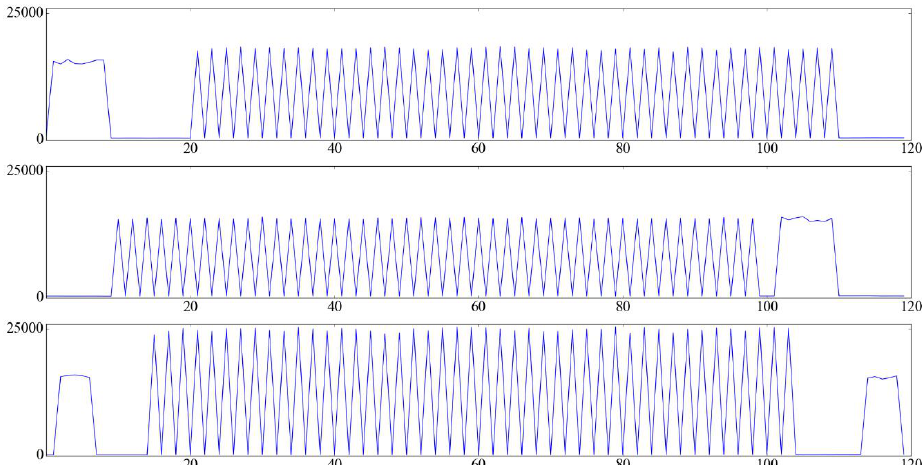
Figure 14. Visualization of feature O from multiple video sequences captured under medium illumination. Axis x denotes the frame index and axis y denotes the value of O .